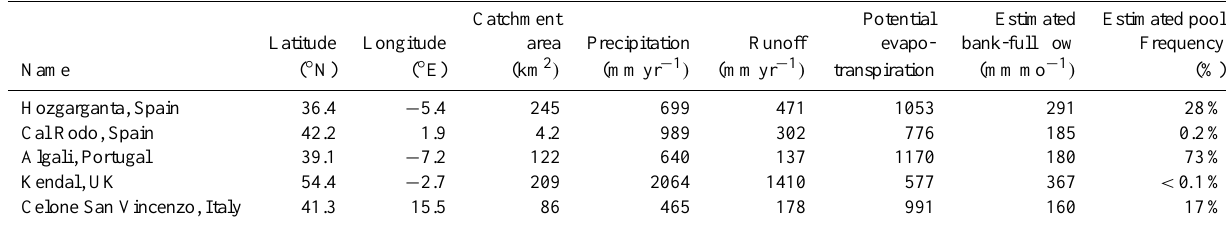
Table 1. Summary characteristics of catchments studied and estimated ‘bankfull’ discharge and ‘pool’ (or lower) flow frequency Catchment Potential Estimated Estimated pool Latitude Longitude area Precipitation Runoff evapo- bank-full flow